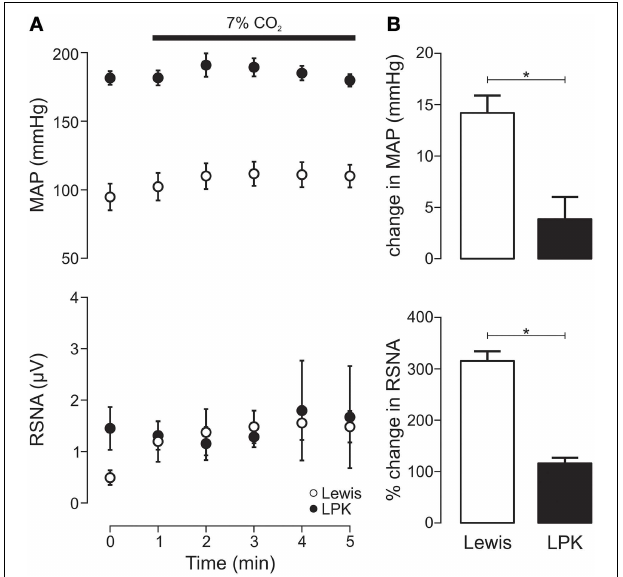
FIGURE 5 | (A) Mean arterial pressure (MAP) and renal sympathetic nerve activity (RSNA) responses to acute open-field stress in Lewis and Lewis Polycystic Kidney (LPK) rats. Data points are 2-min averages of RSNA and MAP measured for 2min before (time zero) and the first 10min during acute stress exposure. (B) Average change in MAP and RSNA during the first 10min of the acute stress exposure. Results are expressed as mean ± SEM. *** p < 0 . 001 . Minimum n /group =